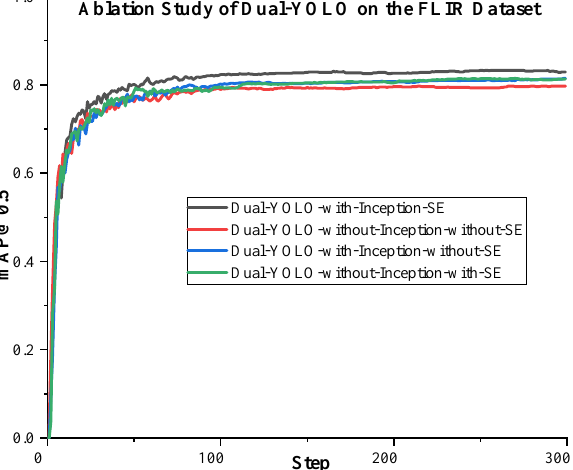
Figure 10. The mAP@0.5 performance curve of Dual-YOLO during training. From the curves, we can see that Dual-YOLO has the highest accuracy when it adds Inception and the SE module together. Table 9. Object detection results of the synthesized images obtained by different modules in the attention fusion module on the FLIR dataset. These results are computed at a single IoU of 0.50 and IoU between 0.50 and 0.95. All values are in %.The top results are marked in green. Inception SE Person Bicycle